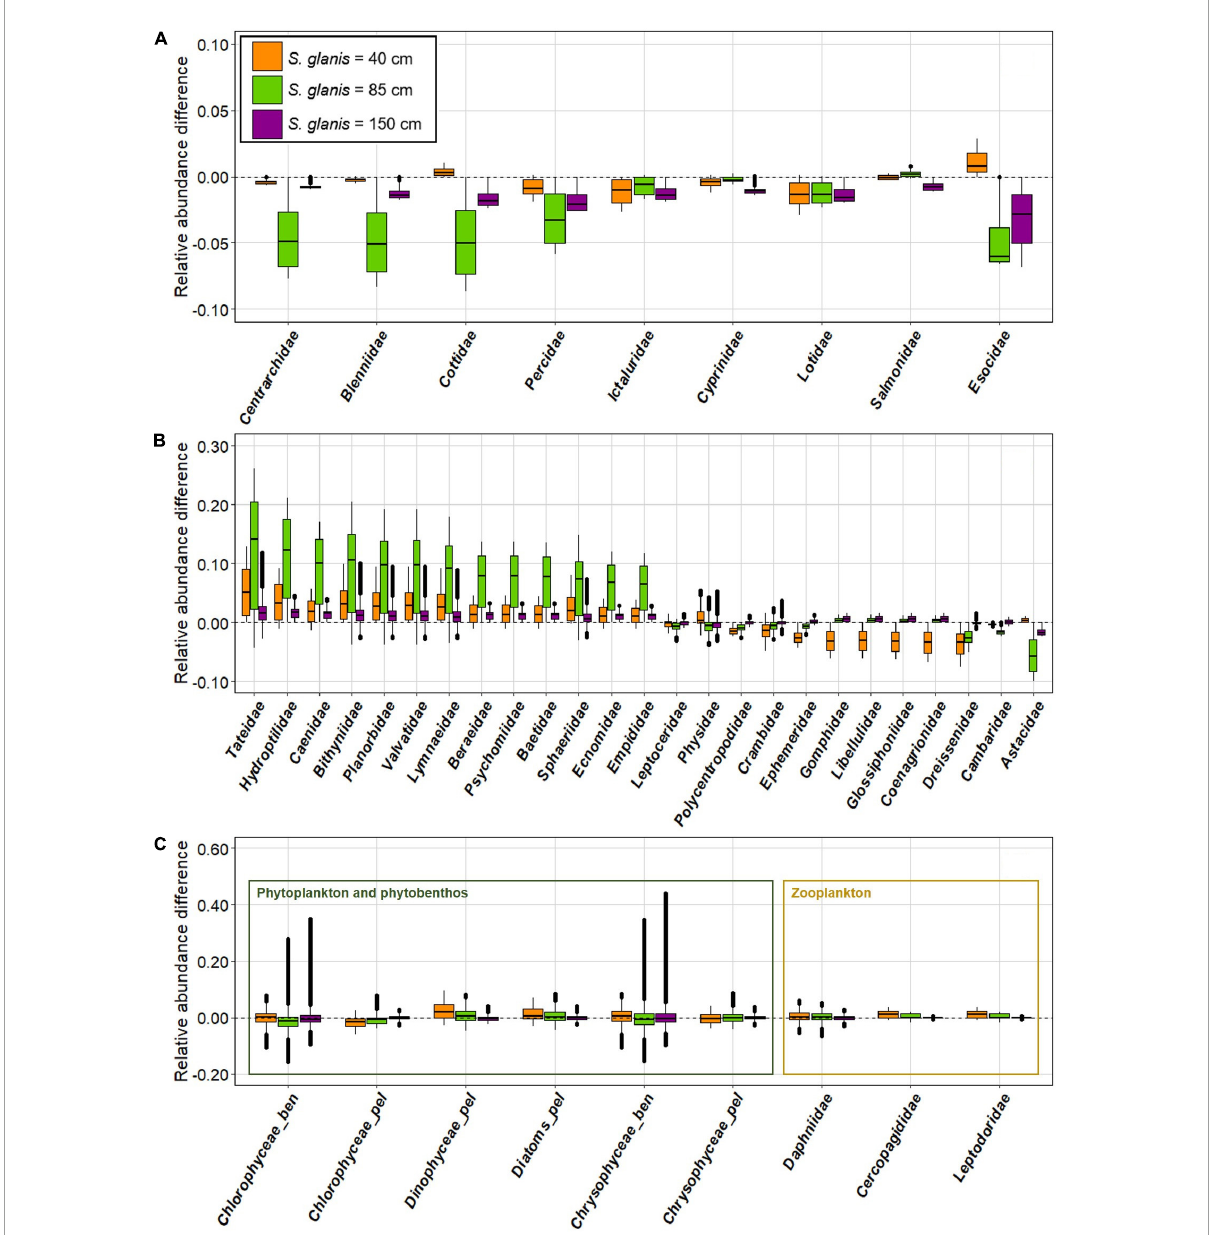
FIGURE3 Relative abundance differences (RAD) along the 20,000 time steps for each invasion scenario providing the effect of S. glanis on the species clusters of fish (A) , invertebrate (B) and primary producers and zooplankton (C) in the whole invaded food-web typical of large French peri-Alpine lakes. Species clusters are ordered by increasing body sizes from left to right. Boxes comprise 25–75% quantiles and horizontal full lines indicate median values. Median values below 0 correspond to an overall abundance depletion following S. glanis invasion while median values above 0 correspond to an abundance